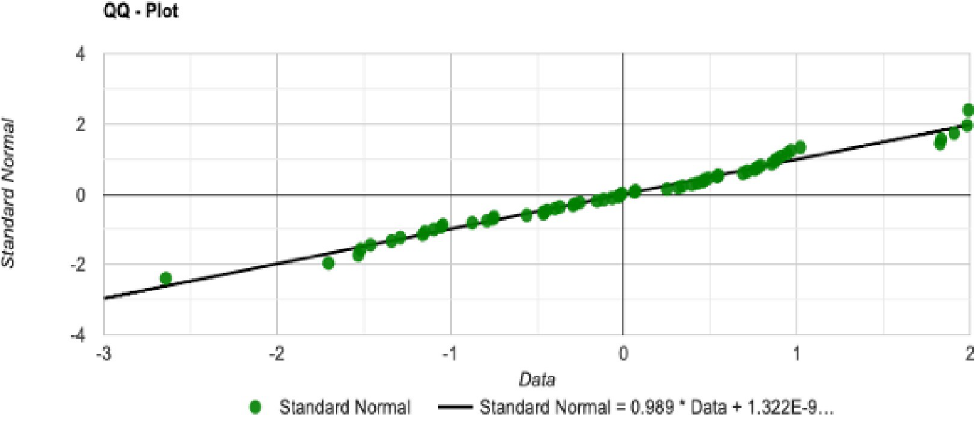
Fig 35. QQ-Plot for the initial tour cost in the SA